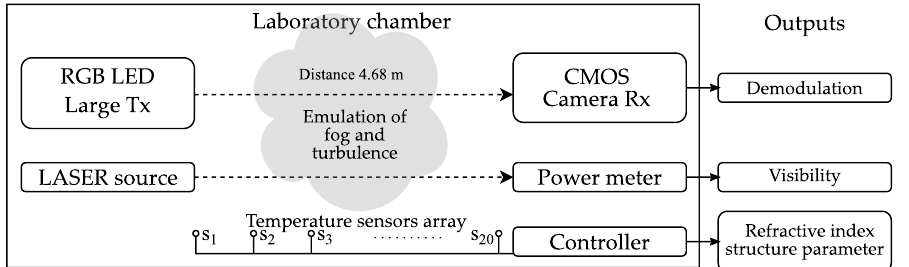
Figure 6. Diagram of the laboratory chamber employed for emulation of atmospheric conditions.